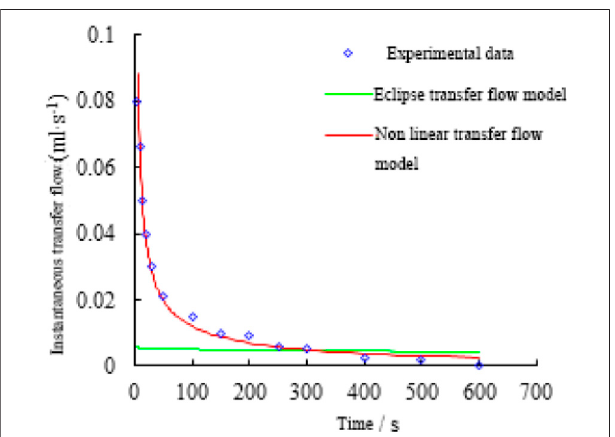
FIGURE 13 | The validation results of different transfer fl ow